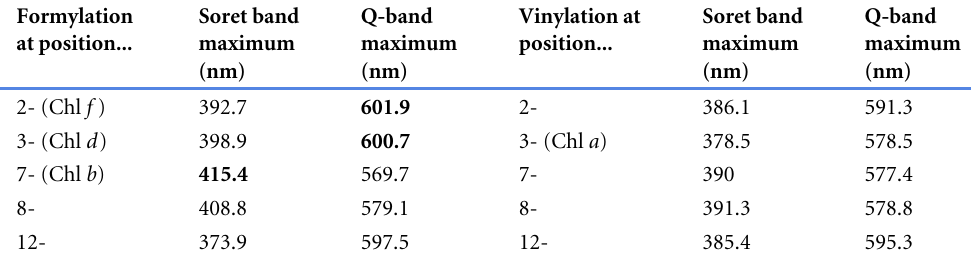
Table 2 TDDFT-computed absorption maxima of the Soret and Q-bands upon single substitutions of chlorophyll a . The largest deviations in band position are highlighted in